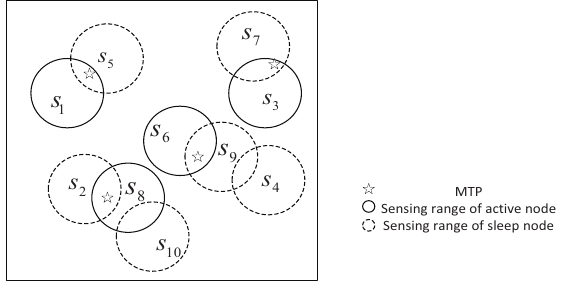
Figure 3. Coding example